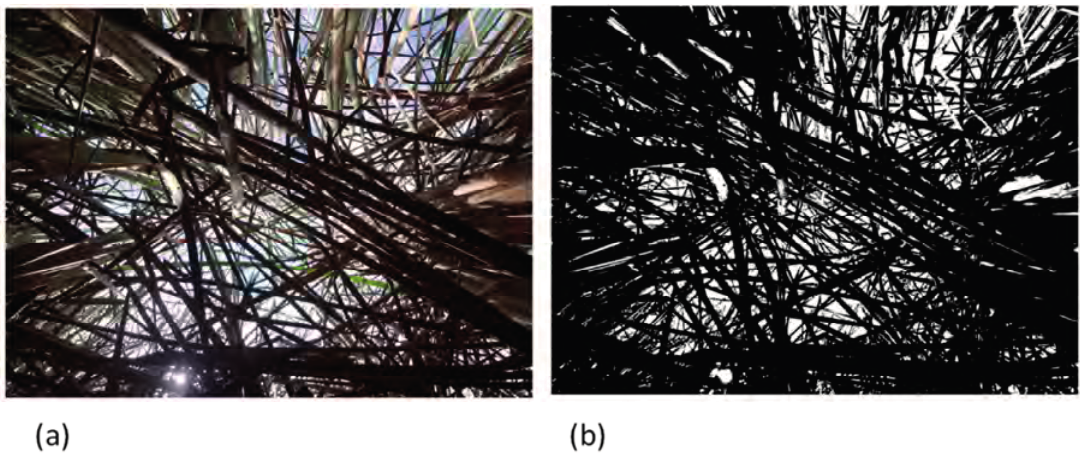
Figure 4. Overall framework of research approach.